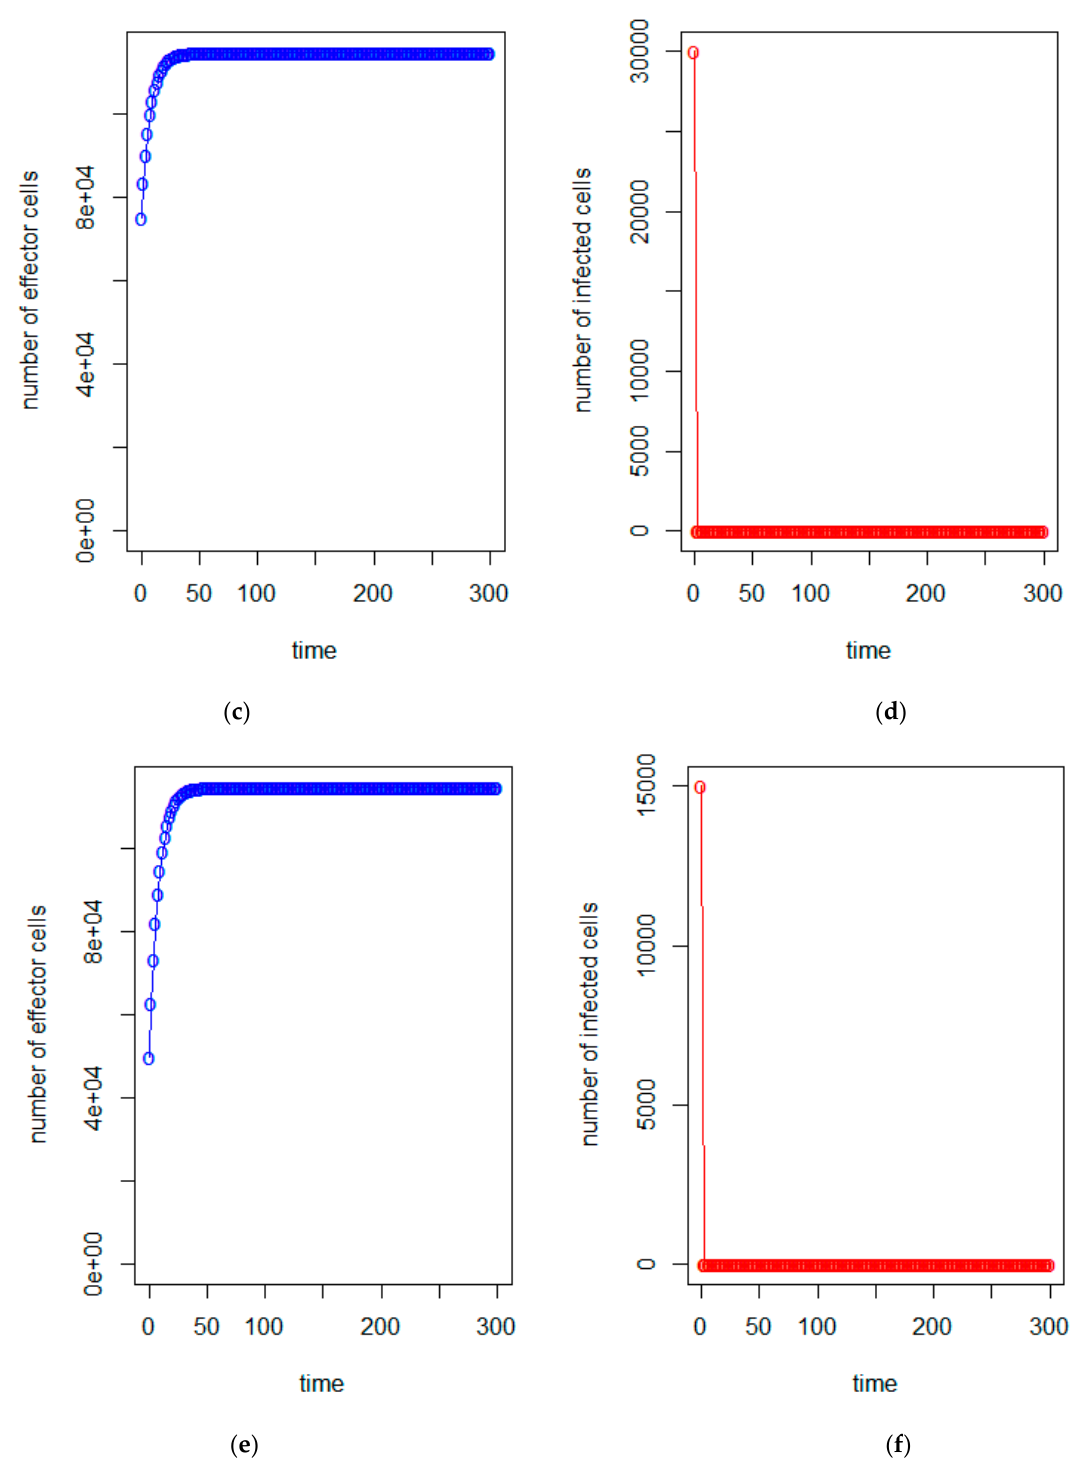
Figure 6. ( a , b ): The immune-effector cells ( a ) and virus-infected cells ( b ) vs. time (days); ( c , d ): When I 0 = 75,000 cells. The immune-effector cells ( c ) and virus-infected cells ( d ) vs. time (days); ( e , f ):When V 0 = 15,000 cells.The immune-effector cells ( e ) and virus-infected cells ( f ) vs. time (days).